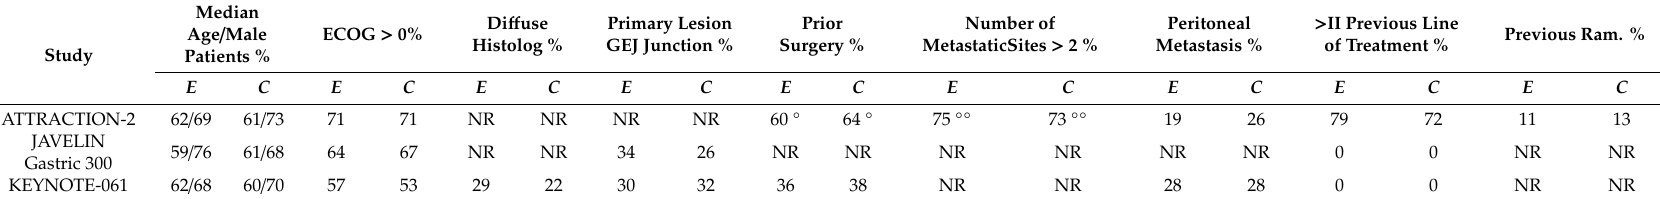
Table 3. Characteristics of patients in the evaluated